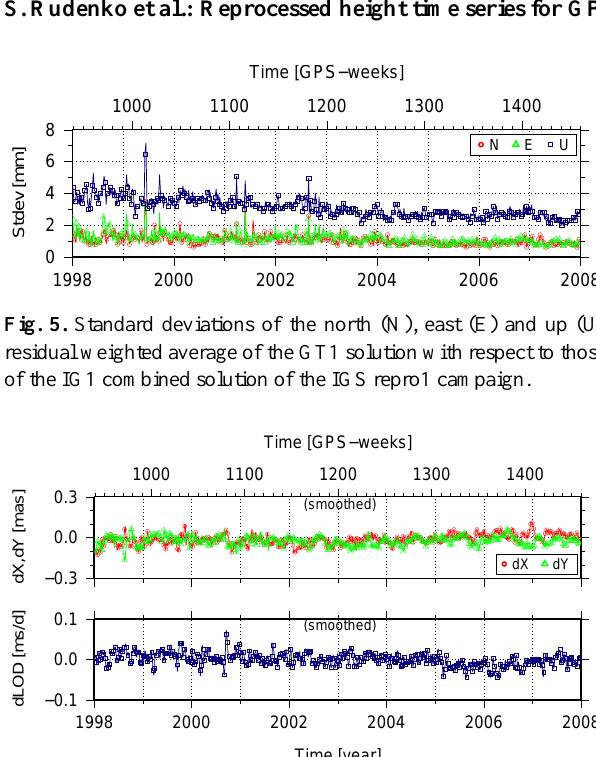
Fig. 6. Comparison of the Earth rotation parameters (X, Y pole co- Fig. 5. Comparison of Earth orientation parameters (Pole coordi- ordinates and LOD) of the GT1 solution with respect to those of the nates X,Y and LOD) of the GT1 solution with respect to IGS com- IG1 combined solution of the IGS repro1 campaign. The plotted bined solution of repro1 (IG1). The plotted values are smoothed